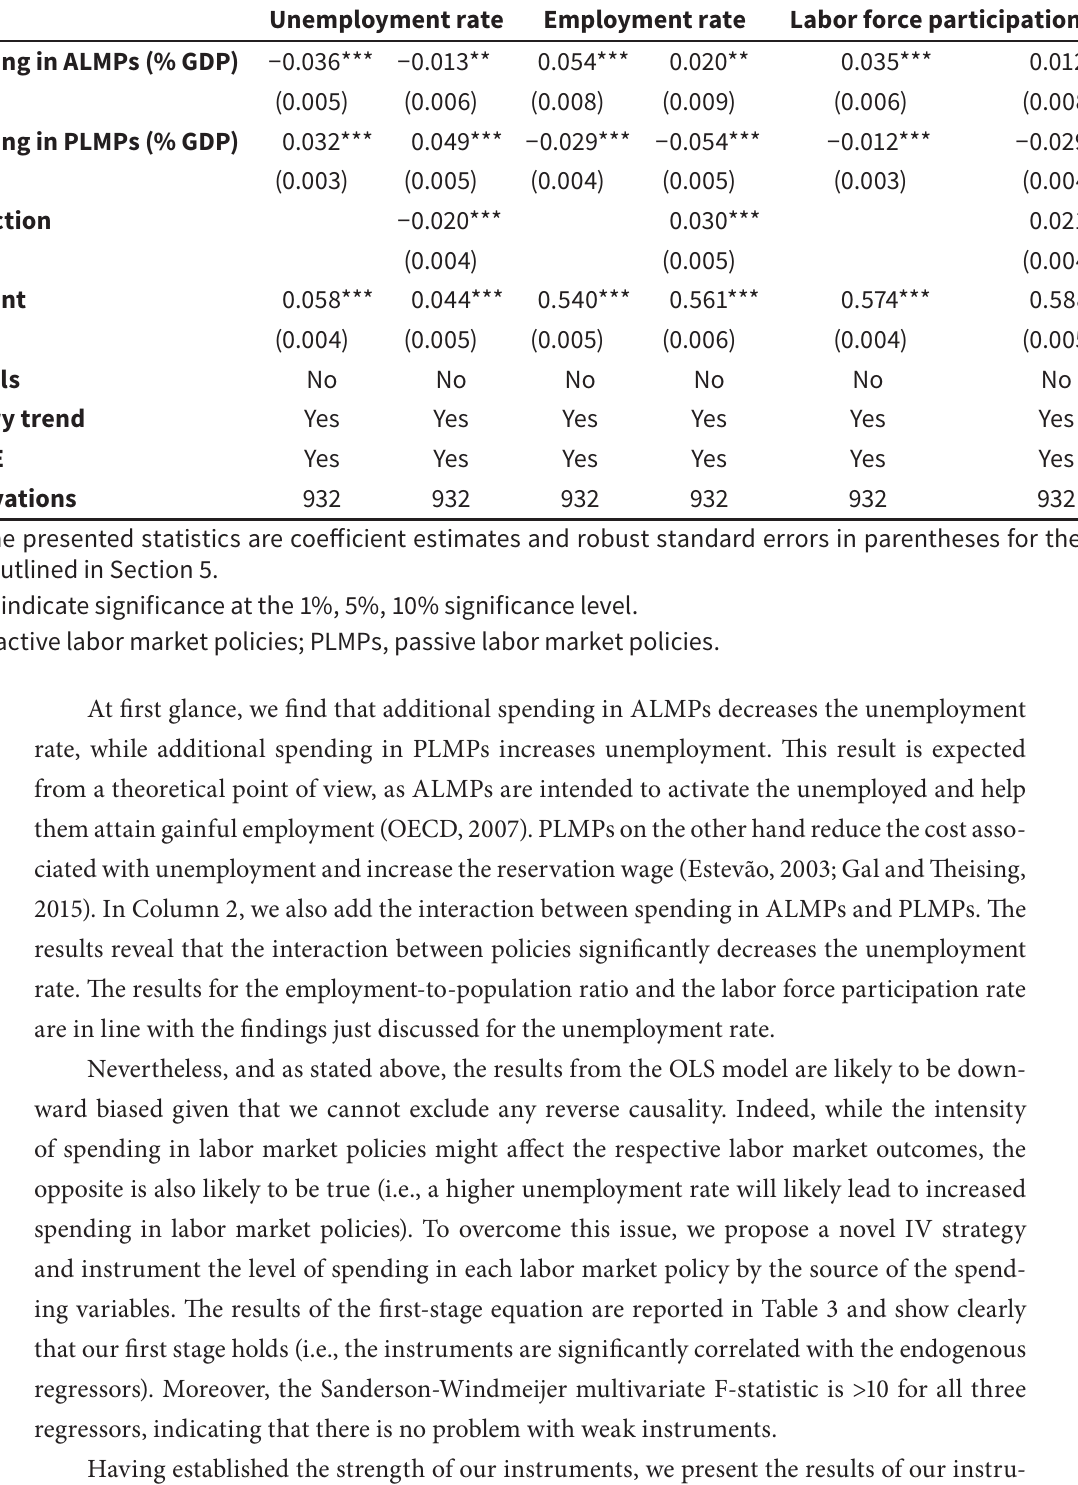
Table 2 . Results for the unemployment rate, employment-to-population ratio, and labor force participation rate estimated with OLS